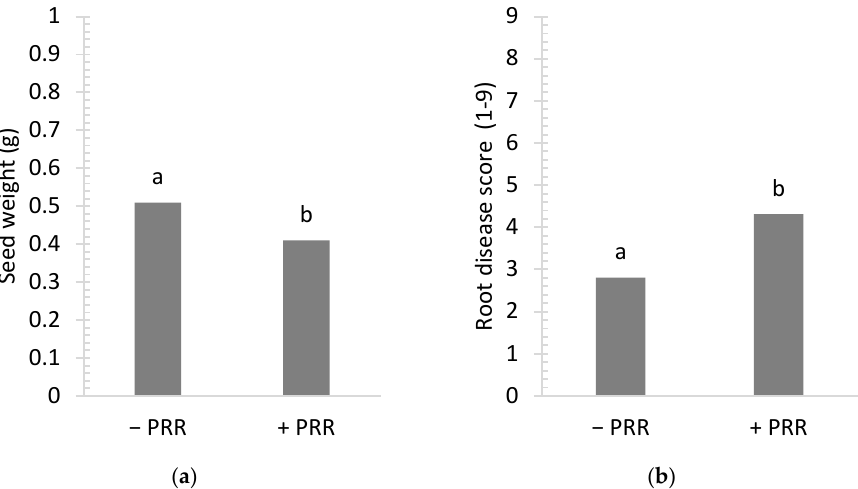
Figure 3. Main effects of Phytophthora medicaginis infection (PRR) on ( a ) seed weight ( p < 0.001) and ( b ) root disease (1 good – 9 poor) ( p < 0.001) in a three-way analysis for three chickpea genotypes and waterlogging (WL) treatments (field capacity (FC), early WL and late WL). Letters indicate significant differences.